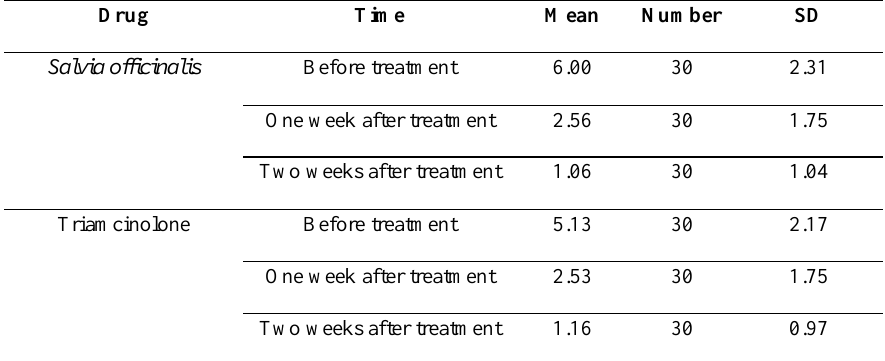
Table 2 . Mean and standard deviation of pain intensity for both drugs at different